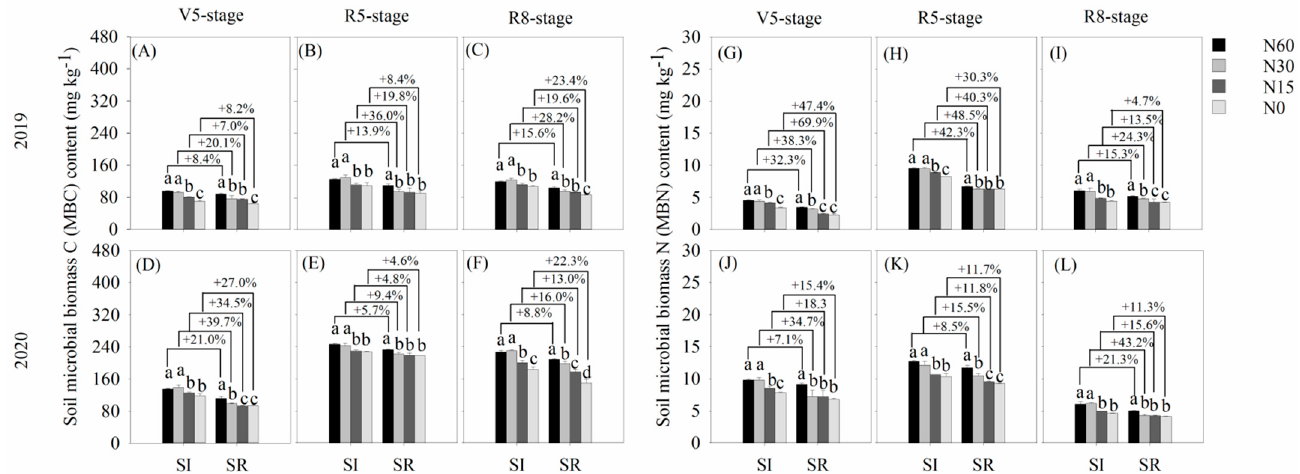
Figure 7. Soil microbial biomass carbon and nitrogen at the different soybean growth stages. ( A ) MBC content at the V5 stage of soybean in 2019, ( B ) MBC content at the R5 stage of soybean in 2019, ( C ) MBC content at the R8 stage of soybean in 2019, ( D ) MBC content at the V5 stage of soybean in 2020, ( E ) MBC content at the R5 stage of soybean in 2020, ( F ) MBC content at the R8 stage of soybean in 2020, ( G ) MBN content at the V5 stage of soybean in 2019, ( H ) MBN content at the R5 stage of soybean in 2019, ( I ) MBN content at the R8 stage of soybean in 2019, ( J ) MBN content at the V5 stage of soybean in 2020, ( K ) MBN content at the R5 stage of soybean in 2020, ( L ) MBN content at the R8 stage of soybean in 2020. In each panel, different lower-case letters “a–d” indicate significant differences under different N application rates within the same straw treatment (LSD, p < 0.05). Same lower-case letters indicate no significant differences under different N application rates within the same straw treatment (LSD, p < 0.05). Data were shown as mean ± S.D. ( n = 3). The values indicate the change in SI relative to SR, and “+” and “ − ” indicate increasing and decreasing, respectively. SI, straw incorporation; SR, straw removal; N60, convention N (60 kg N ha − 1 ); N30, reduced N by 50% (30 kg N ha − 1 ); N15, reduced N by 75% (15 kg N ha − 1 ); N0, zero N (0 kg N ha − 1 ); V5, the fifth trifoliolate stage of soybean; R5, the beginning seed stage of soybean; R8, the full-maturity stage of